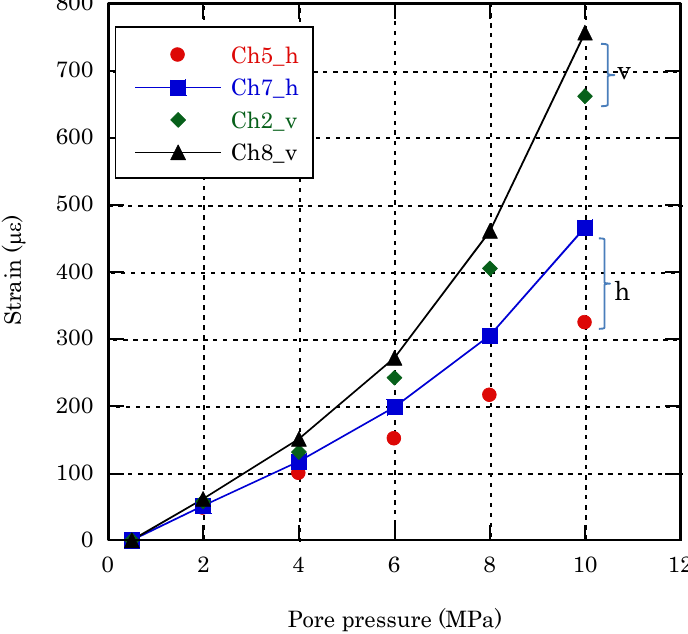
Figure 9. Berea core strain gauge measurements showing considerable variations between the vertical and hoop strains and a largely piecewise increase in the strains with increasing pore pressure.